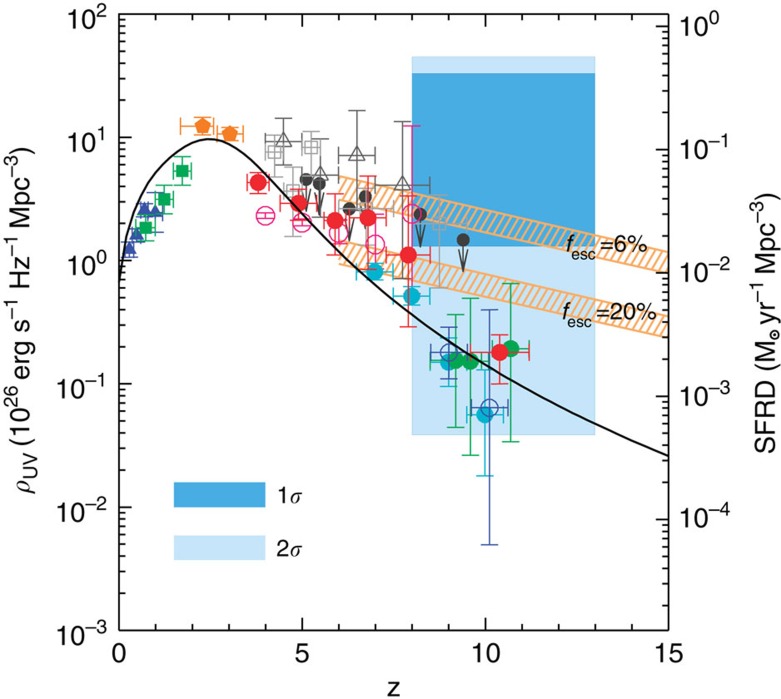
The ultraviolet luminosity density and star-formation rate density as measured with intensity fluctuations.Plotted here is the specific ultraviolet luminosity density (left axis), with the equivalent star formation rate density (SFRD, right axis), as a function of the redshift z. We show the 1σ and 2σ error bounds in our redshift bin as the light and dark blue regions. Results from low-redshift surveys are shown as blue triangles62, bright green squares63, and orange pentagons64. At z∼4 to 10 the star formation rate density is shown to decrease with increasing redshift as measured by previous works, plotted as filled cyan circles65, filled red circles6, open red circles7 filled green circles45 and open blue circles3. Gamma ray burst (GRB) studies are shown as grey triangles66, squares67 and dark grey circles68. Except for ref. 65, other estimates are luminosity function extrapolations and integrations down to MUV=−13. Our measured star formation rate densities are consistent with previous works between z∼8 to 10, however only extremely bright galaxies are directly detected in the aforementioned works with extrapolations down to MUV=−13 involves the measured faint-end slope of the luminosity function. For reference we plot the theoretically expected relation69 between ultraviolet luminosity density and redshift to reionize the universe and/or to maintain reionization using an optical depth to reionization of τ=0.066±0.012 (ref. 8). We take a gas clumping factor of C=3 and show two cases where the escape fraction of galaxies fesc is 6 and 20% (see also ref. 47).